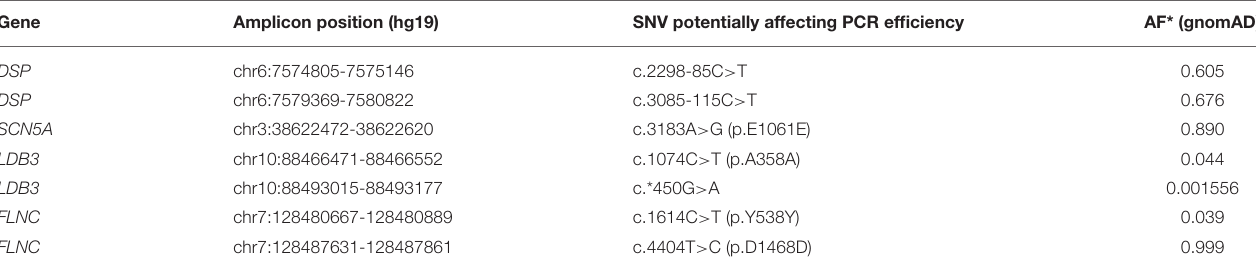
TABLE 2 | SNVs localized in the oligoprimers’ binding sites and threatening PCR